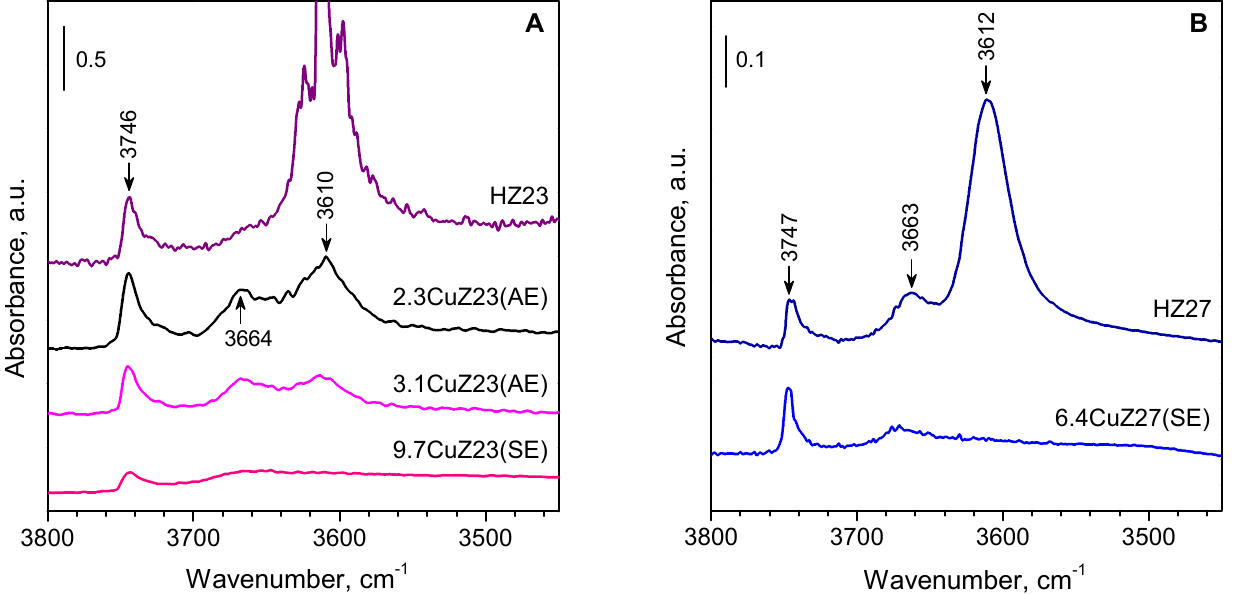
Figure 2. ( A , B ) IR spectra in the ν (OH) region of the parent and the Cu-exchanged zeolites. All samples were preliminary evacuated at 400 °C.